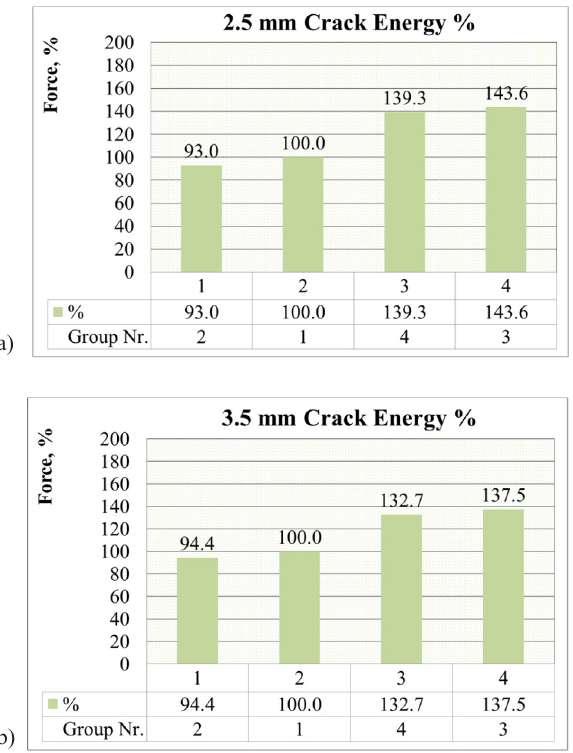
Fig. 11. Energy spent reaching COD equal to 2.5 mm (a), and 3.5 mm (b), Group 1 is designated